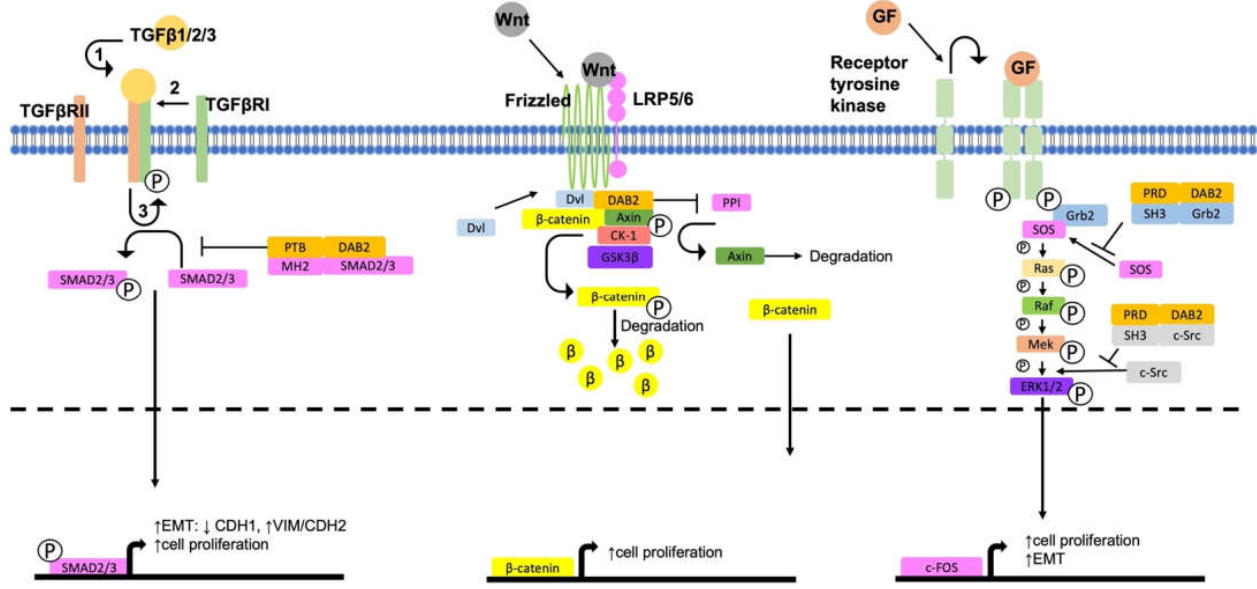
Figure 2. Regulatory role of DAB2 in MAPK, Wnt/β-catenin and canonical TGFβ pathways. In the absence of DAB2, TGFβ1/2/3 activate canonical signalling pathways through dimerisation of receptors TGFβRI and TGFβRII. This activates SMAD2 and enhances cell proliferation and EMT through expression of target genes. DAB2 PTB domain directly interacts with the MH2 domain of SMAD2/3, preventing its activation. DAB2 inhibits the canonical Wnt signalling pathway by preventing the interaction between Dvl and Axin, preventing destruction of the β-catenin destruction complex. In the absence of DAB2, Dvl and Axin interact separating the complex. β-catenin is then free to translocate to the nucleus where it promotes cell proliferation through expression of target c-myc and cyclin D1. DAB2 PRD interacts with the SH3 domains of SOS and c-Src in the MAPK pathway, inhibiting the signal transduction and in turn inhibiting cell proliferation and EMT.